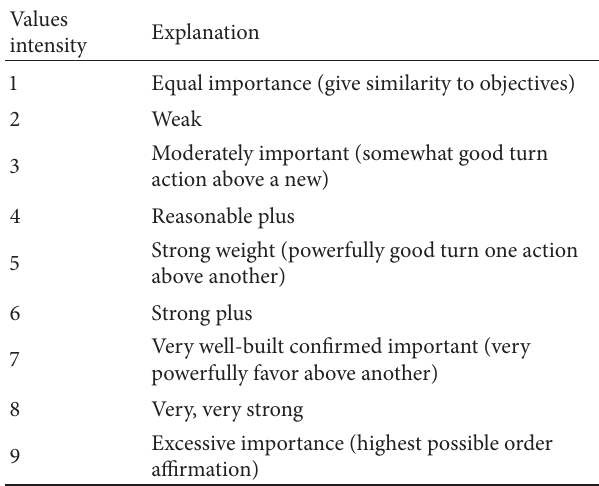
Table 2: Scale for